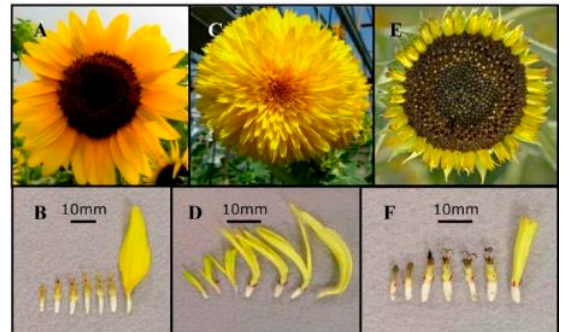
Figure 3. Capitulum and florets of a wild-type sunflower plant and two mutants [79]. ( A , B ) Wild-type sunflower with disc and ray florets. ( C , D ) dbl mutant with disc and ray florets. ( E , F ) tub mutant with disc and ray florets. The florets from the disc center to the peripheral florets are arranged from left to right. Reprinted with permission from Ref. [79]. Copyright © 2023 Chapman et al.